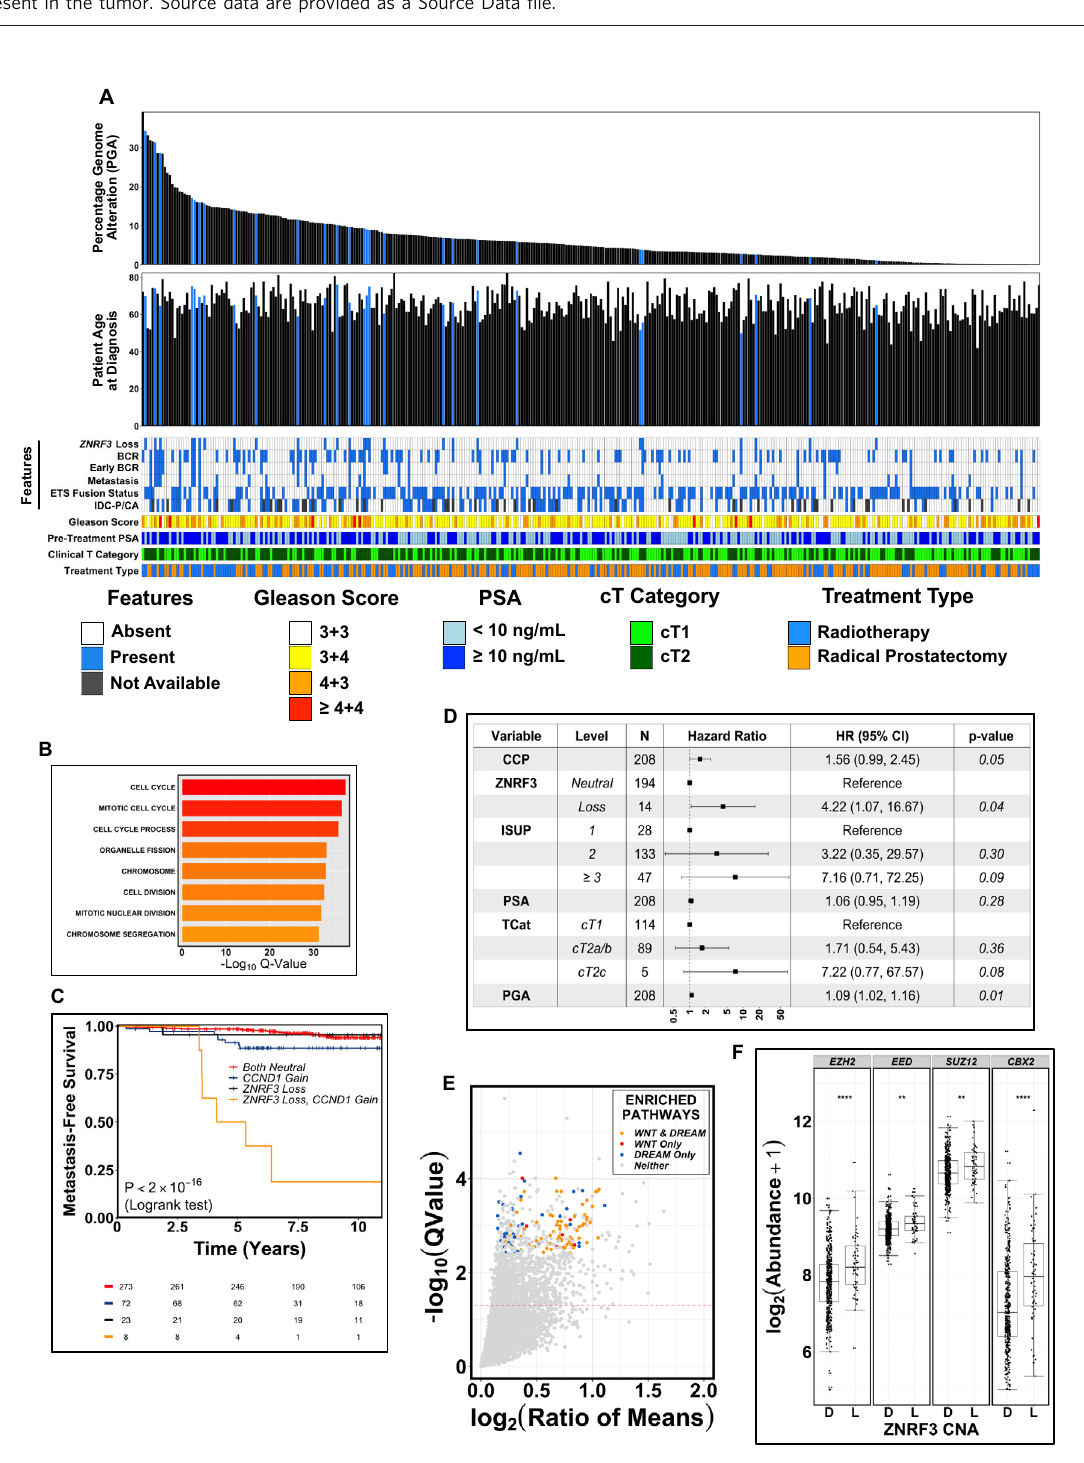
Fig. 4 Aberrant methylation of ZNRF3 in aggressive localized prostate cancer. A The ZNRF3 5 ’ promoter (probe cg11986861) is signi fi cantly hypermethylated in localized prostate cancers harboring low ZNRF3 RNA abundance. Coordinates refer to the GRCh37 (hg19) human genome build. Blue dots represent probes with statistically signi fi cant differential methylation ( Q < 0.05). B ZNRF3 RNA abundance is inversely associated with methylation of the ZNRF3 5 ’ promoter. Shaded area shows 95% con fi dence interval of the best fi t line. Two-sided p -value generated from a permutation test. C , D ZNRF3 5 ’ promoter methylation is signi fi cantly elevated in tumors harboring ZNRF3 allelic losses. p -values from a Mann – Whitney U test. CPCG: n = 286 patients; TCGA: n = 493 patients. Centre of box represents the median value. Lower and upper box hinges correspond to the fi rst and third quartile. Whiskers extend to the largest and smallest values no further than 1.5-times the Interquartile Range. E , F Patients whose tumors harbor >1 aberrant ZNRF3- associated feature (i.e. monoallelic loss, low RNA abundance, 5 ′ promoter hypermethylation) are at signi fi cantly higher risk of metastatic relapse ( E ; CPCG) and disease progression ( F ; TCGA) than those patients with one or no features. p -values from a log-rank test. Colors indicate the number of features present in the tumor. Source data are provided as a Source Data fi